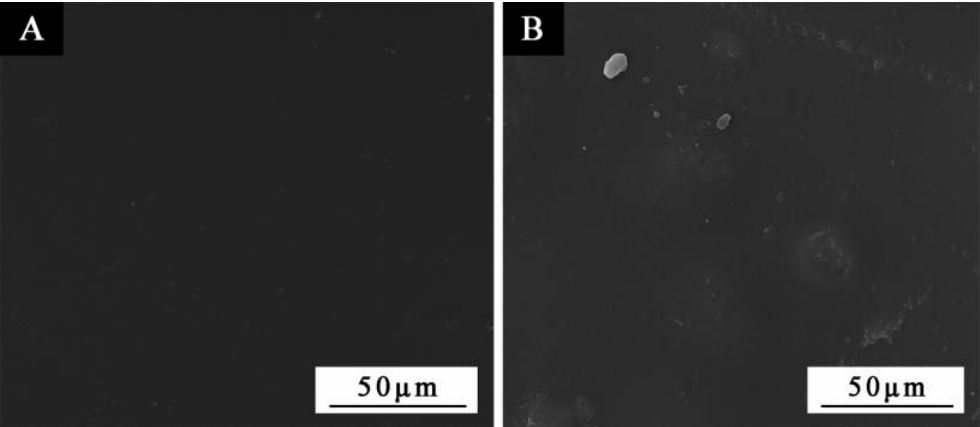
Figure 4. SEM of the paint film with “3 layers of primer, 2 layers of topcoat”: ( A ) 0; ( B ) 10.0% microcapsules in primer.